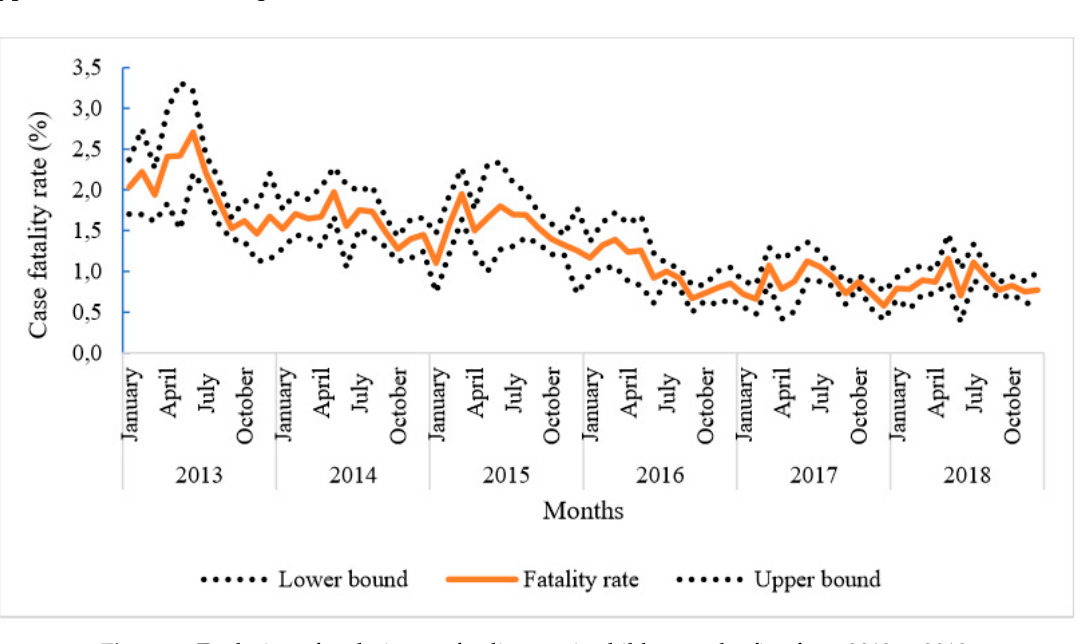
Figure 1. Evolution of malaria case fatality rate in children under five from 2013 to 2018.